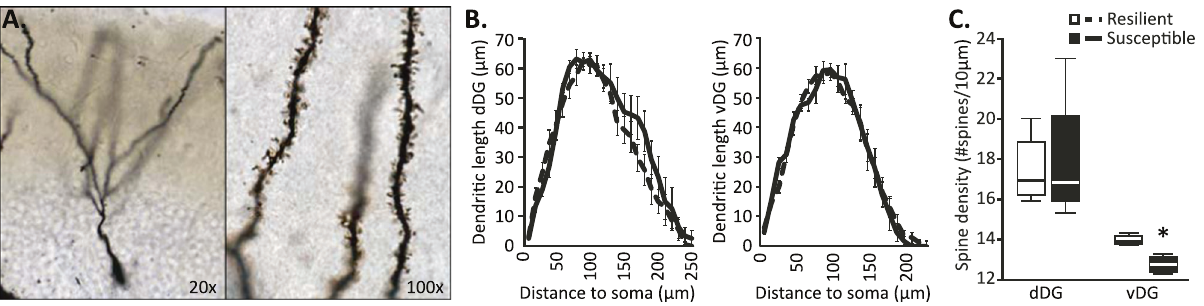
Fig. 1 Morphology of DG granule cells in susceptible and resilient mice. Reconstruction of Golgi-stained DG granule cells ( A ) in behavioral cohort 1 revealed no differences in dendritic length between the dorsal (dDG) or ventral DG (vDG) ( B ), but indicated reduced spine density in the ventral DG of susceptible animals, whereas no differential spine density was observed in the dorsal DG ( C ). Behavioral results for this cohort are depicted in Figure S3. * p <